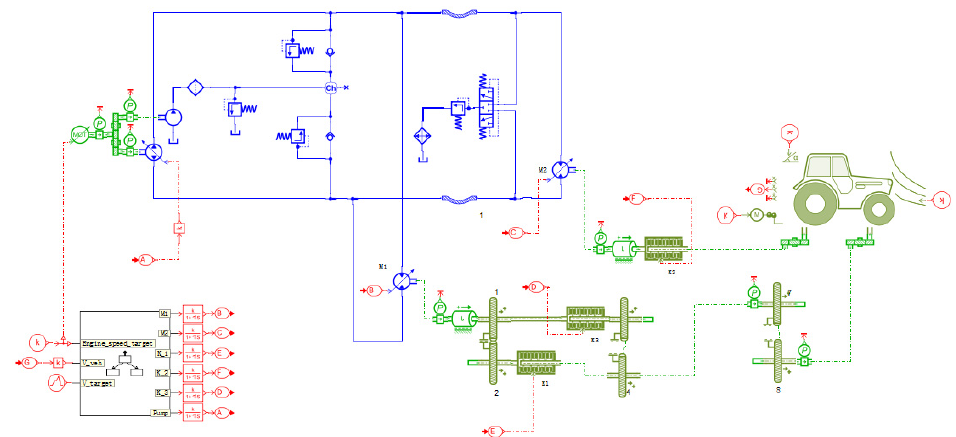
Figure 5. Model of hydraulic travel system based on state machine control.